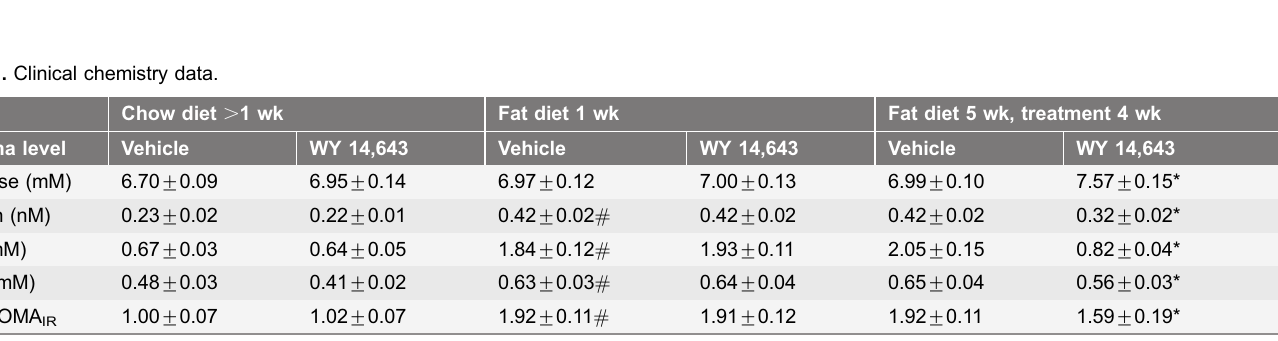
Table 1. Clinical chemistry